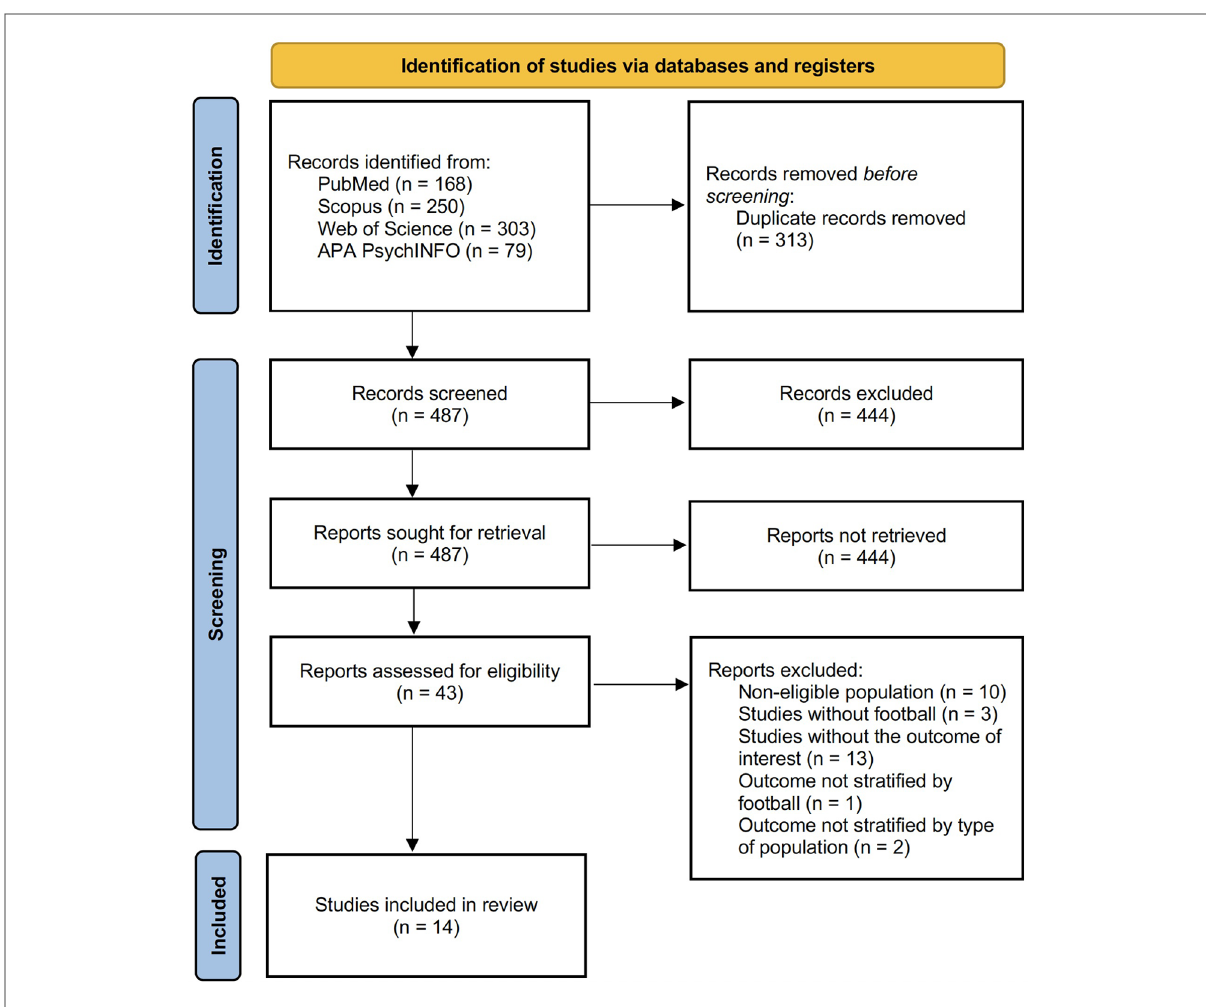
FIGURE 1 PRISMA 2020 fl ow diagram of included